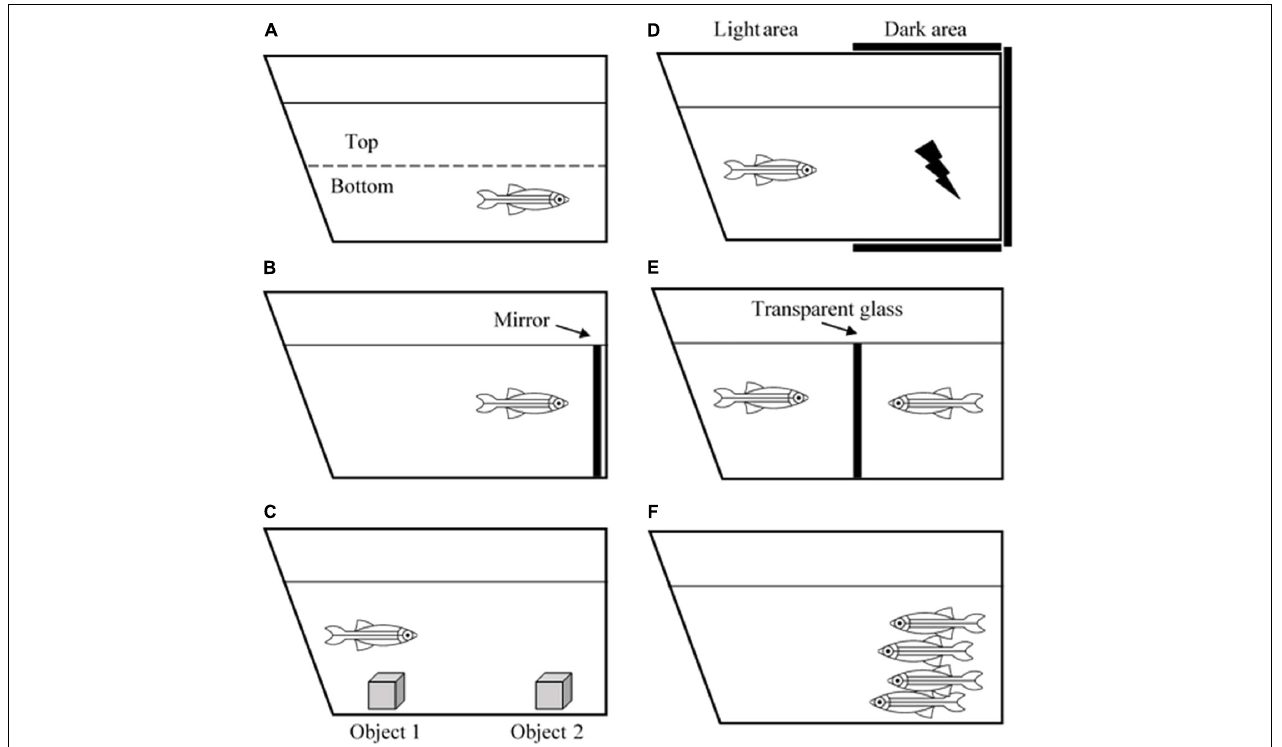
FIGURE 1 | Illustration of zebrafish behavioral tests. (A) Novel tank test, (B) mirror test, (C) object discrimination test, (D) avoidance learning test, (E) male-male interaction test, and (F) shoaling